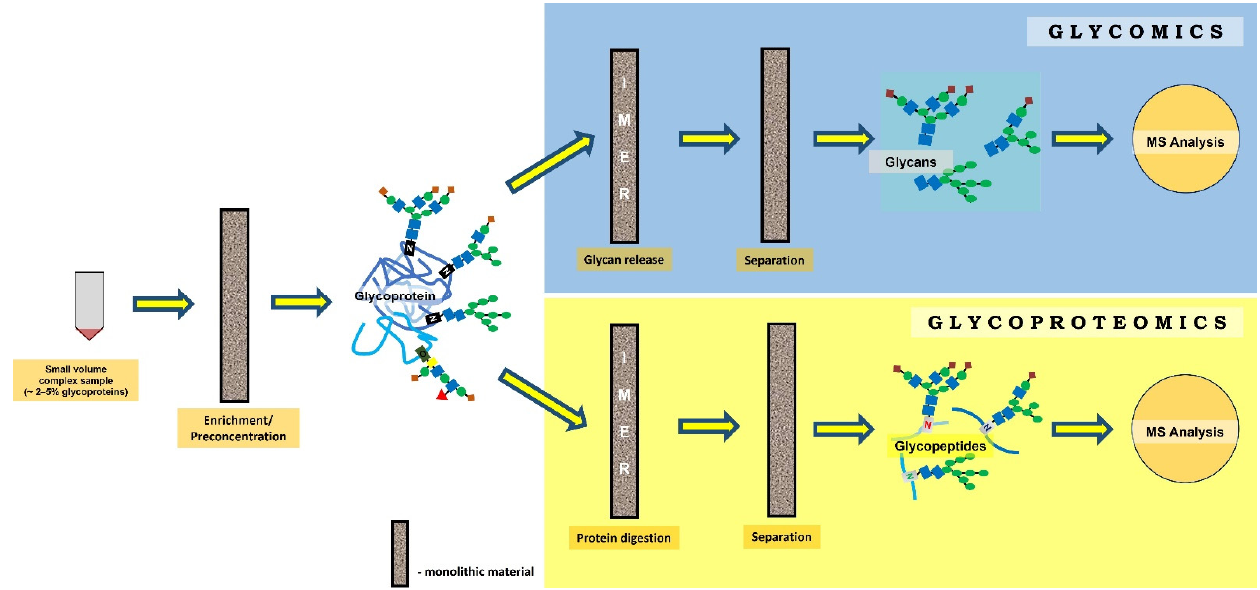
Figure 1. Use of monolithic materials in glycoprotein analysis as solid supports in protein digestion, glycan release, enrichment, and separation processes. The approach in glycoprotein analysis can be either towards glycomics through glycan analysis or towards glycoproteomics through glycopeptide